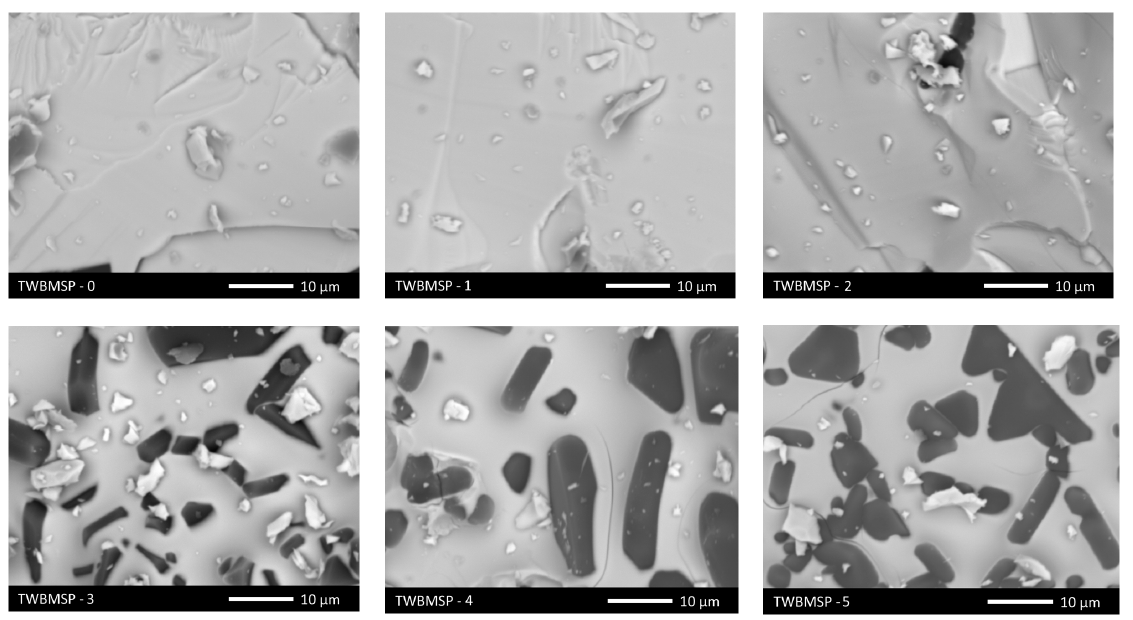
Figure 2. SEM images of the morphology of the synthesized ceramics depending on the concentration of the PbO dopant.